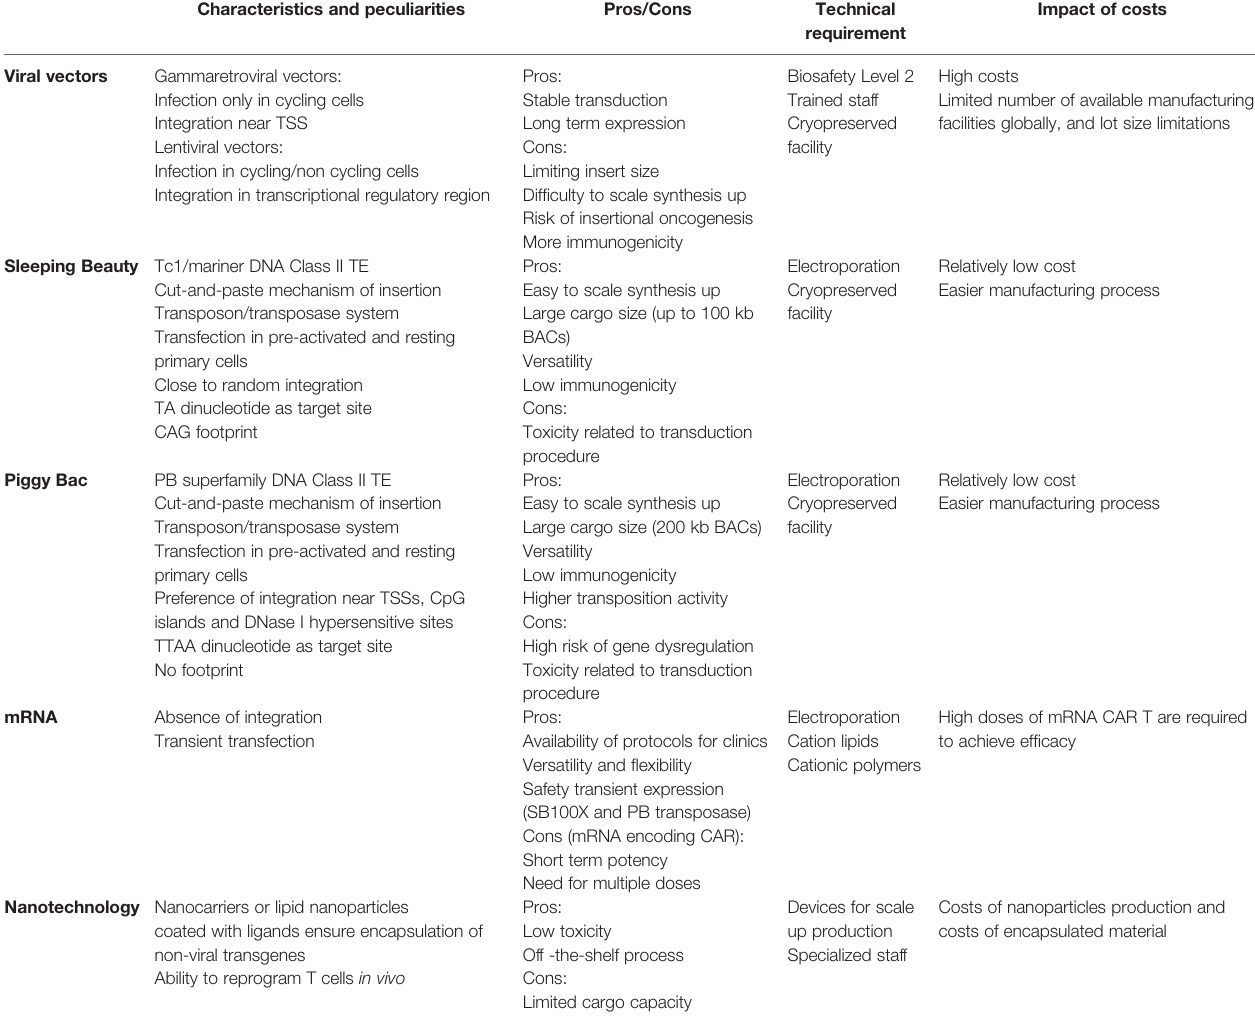
TABLE 4 | Summary of principal characteristics of methods in CAR T manufacturing. Characteristics and peculiarities